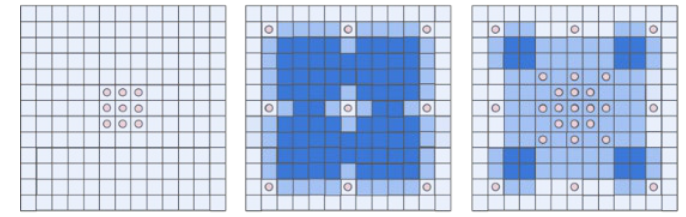
Figure 4. Visualization of receptive fields and grid effects.